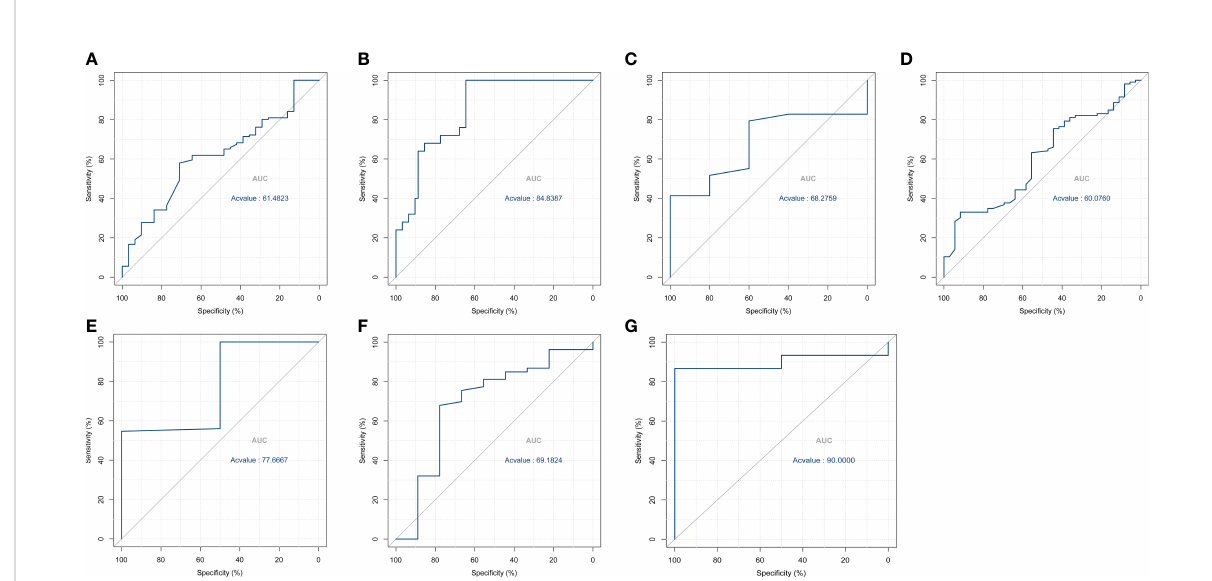
FIGURE 10 ROC curves of the virtual fi lter for (A) isoliquiritigenin; (B) medrysone; (C) benzoic acid; (D) oxymetholone; (E) sulforaphane; (F) pevonedistat; (G)